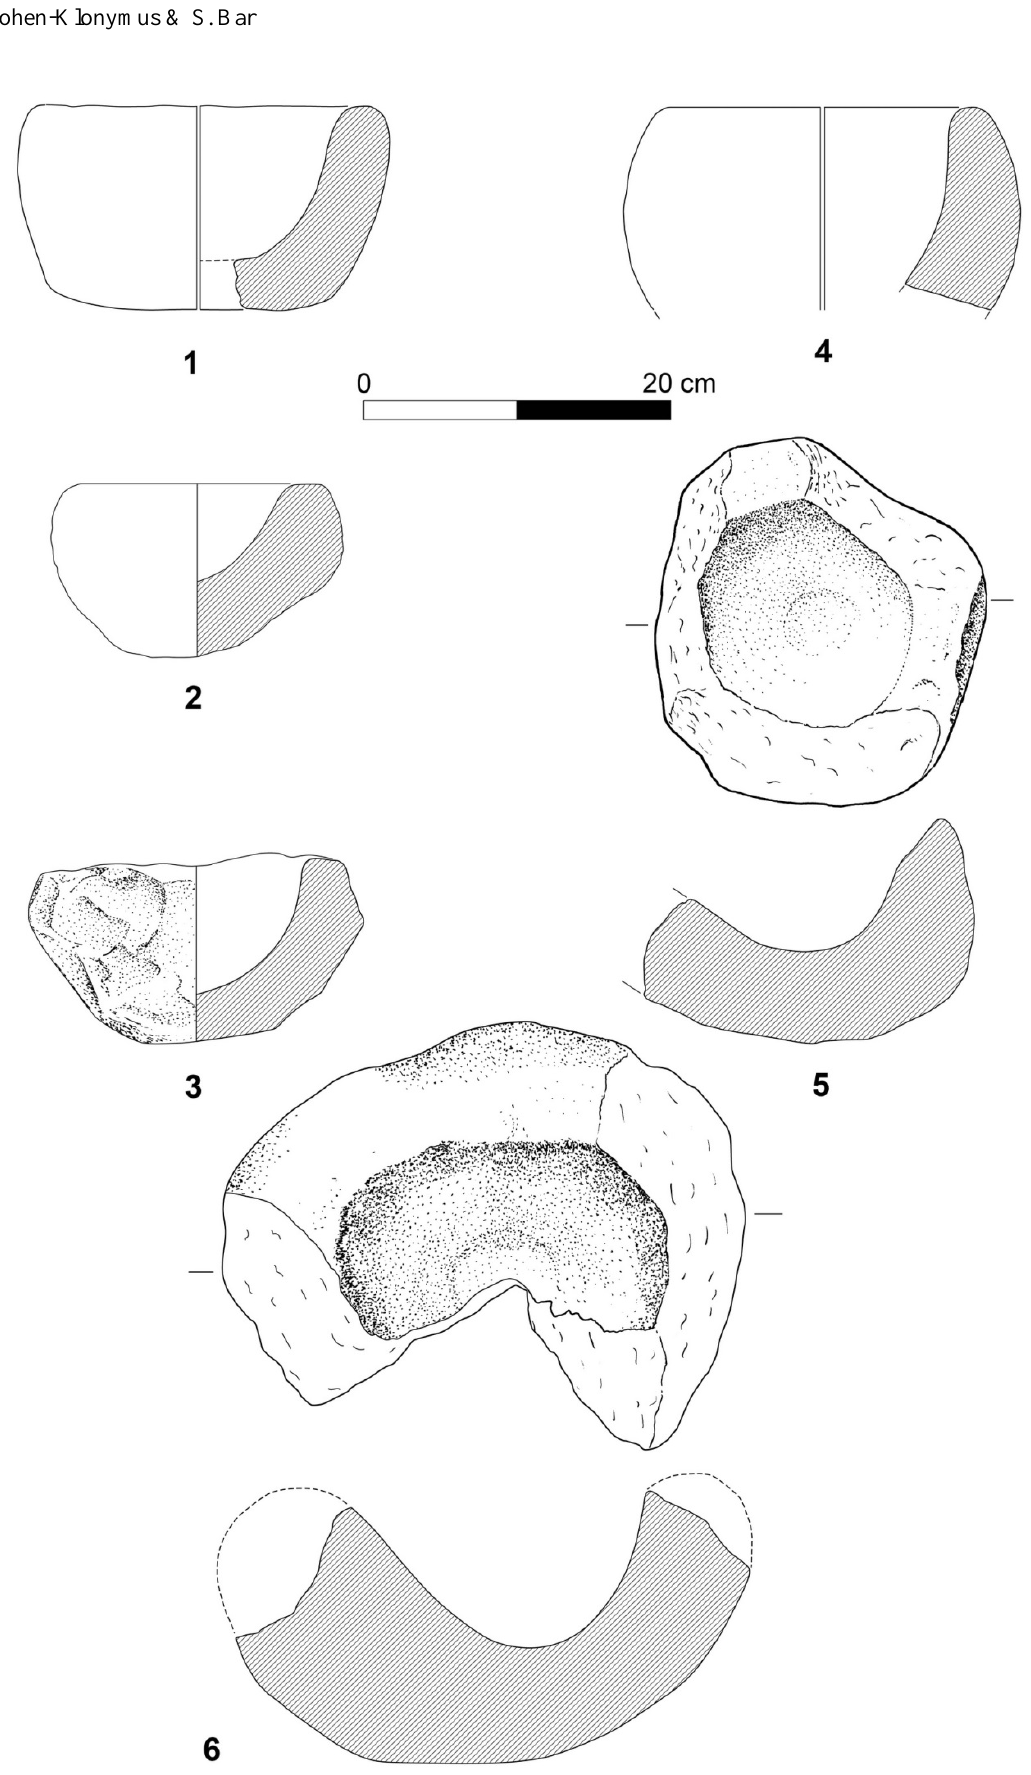
Figure 7. Mortars from Fazael 2 (items 1-3) and Fazael 7 (items